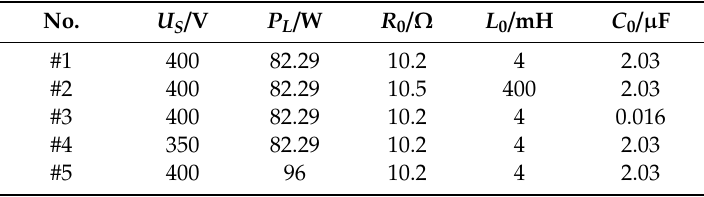
Table 5. Five parameter sets for prototype